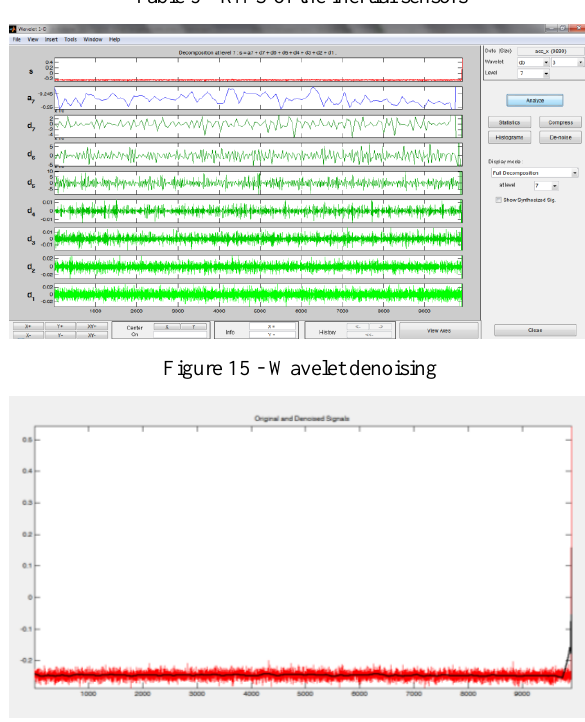
Figure 16 - Original (red) and de-noised (black) signals